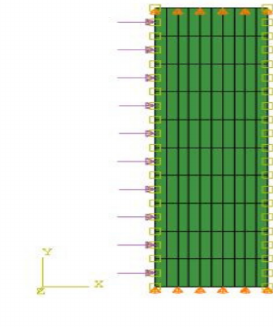
Figure 4. Meshing, boundary conditions, internal pressure, and thermal gradient of axisymmetric thick